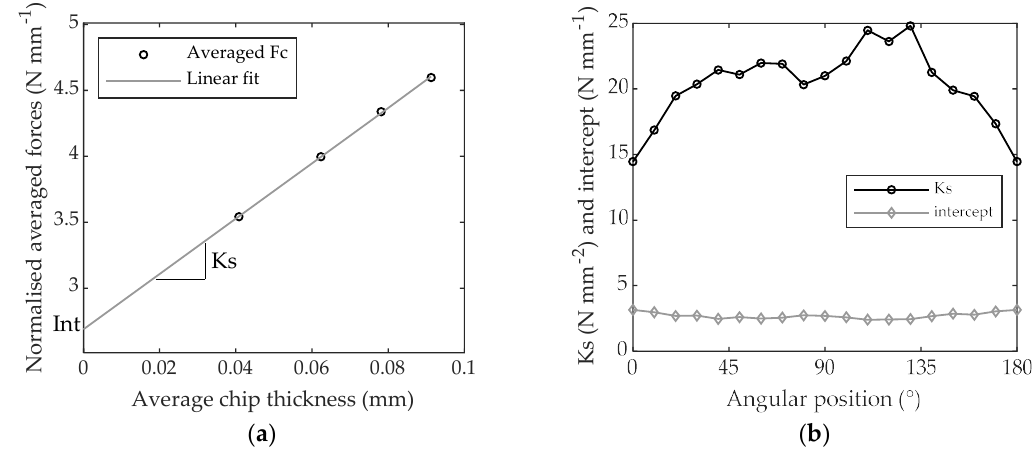
( b ) Figure 9. Cutting forces machining with different depths of cut (0.3, 0.7, 1.1 and 1.5 mm): ( a ) average force per revolution for every degree of angular position ( 𝐹𝑐 ); ( b ) average cutting force referring to the cutting period reported every 10° of angular position ( 𝐹 (cid:3004) (cid:3364)(cid:3364)(cid:3364) ). Once the values of ( 𝐹𝑐(cid:3364)(cid:3364)(cid:3364) ) were extracted every ten degrees, they were plotted against chip